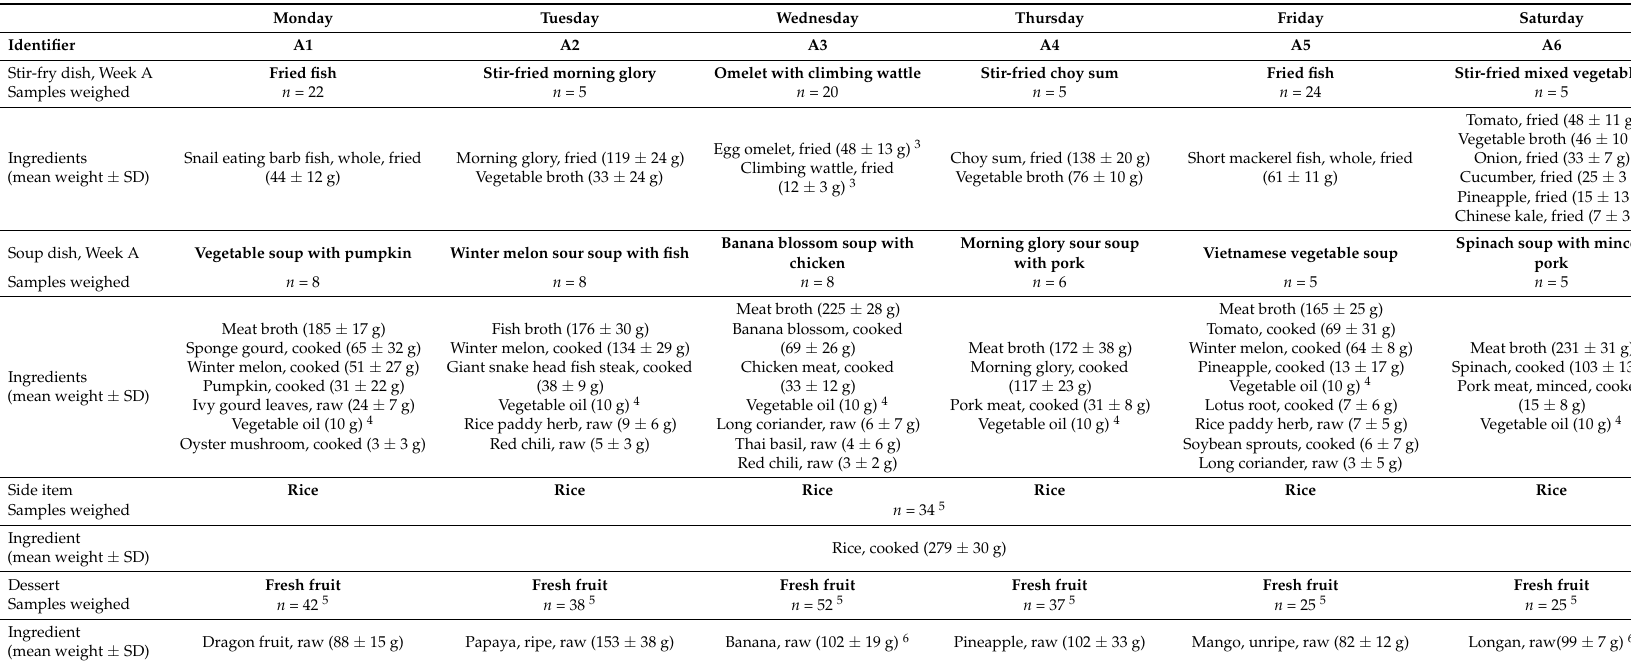
Table A1. Amount by weight of ingredients in low-price model lunch sets served at a garment factory in Phnom Penh, Cambodia (Week A) 1,2